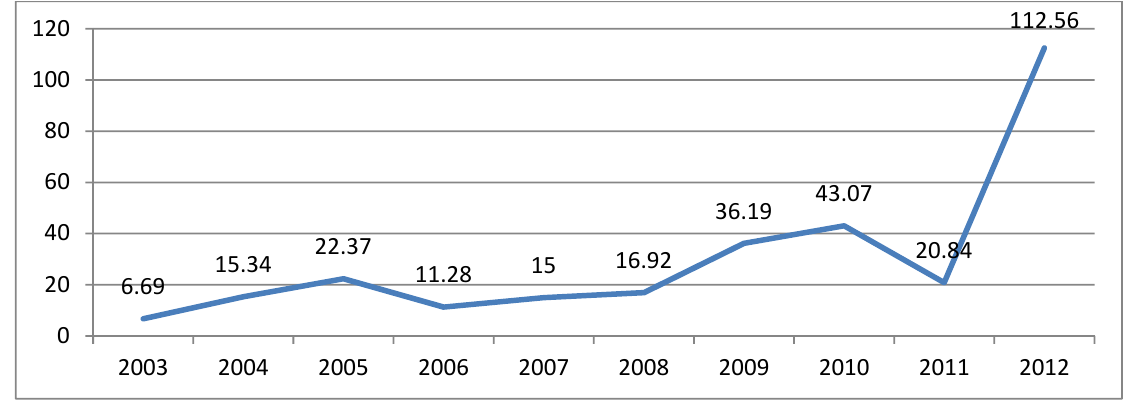
Fig. 1. Trend of confiscated smuggled cosmetic